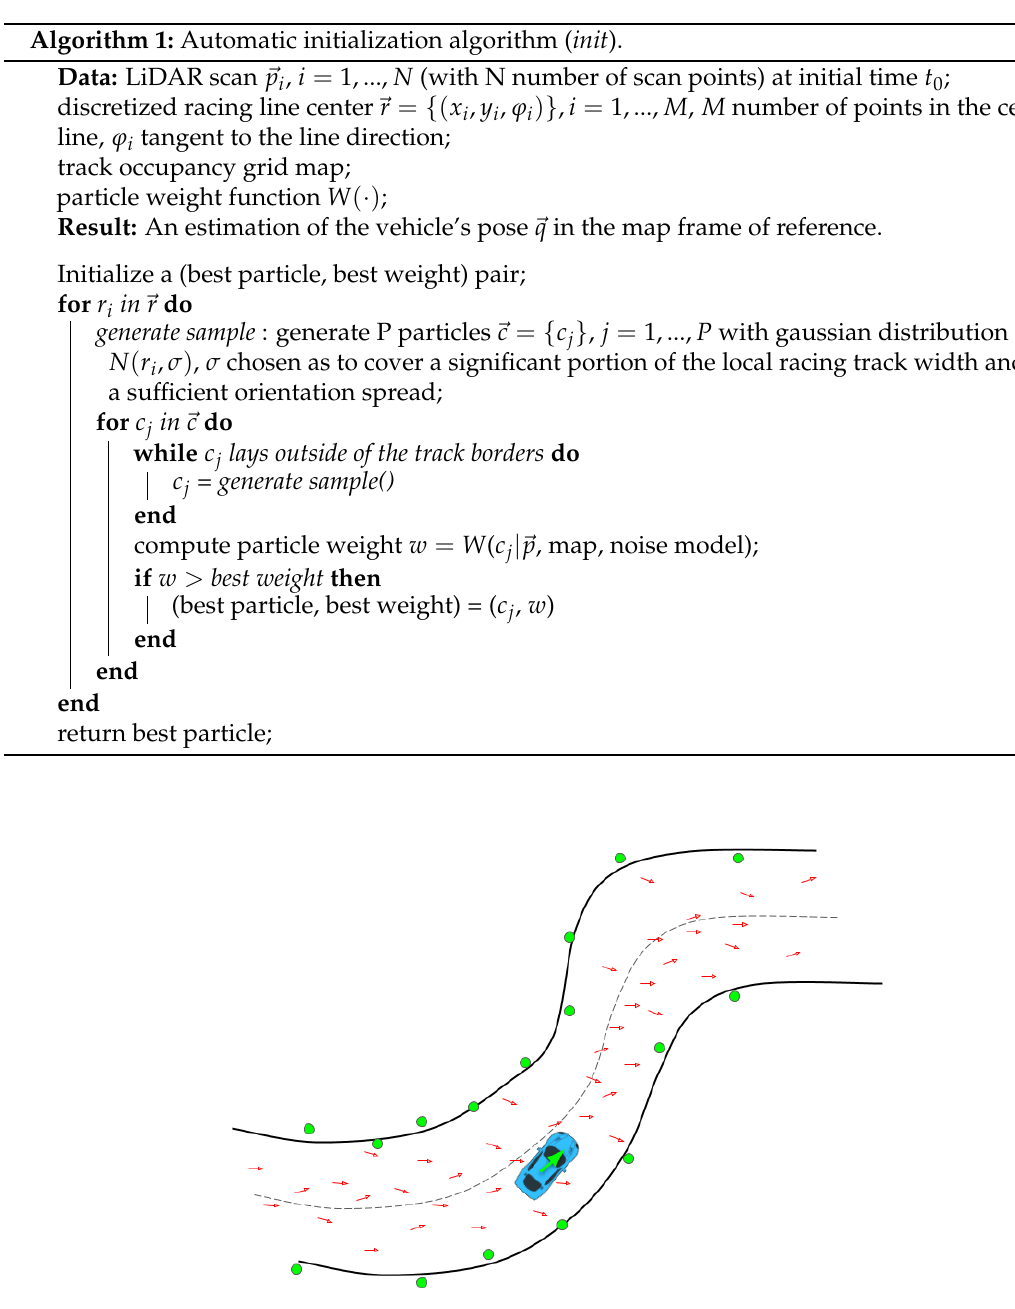
Figure 7. Representation of the automatic initialization procedure: a number of particles is generated with a Gaussian distribution around the track center line within the admissible state space (the inner area of the racing track), while limiting the particles orientation along the race direction. Each particle is represented by a red arrow; we rotate and translate the LiDAR point cloud around each red arrow, and compute the best matching particle, whose resulting match is shown in